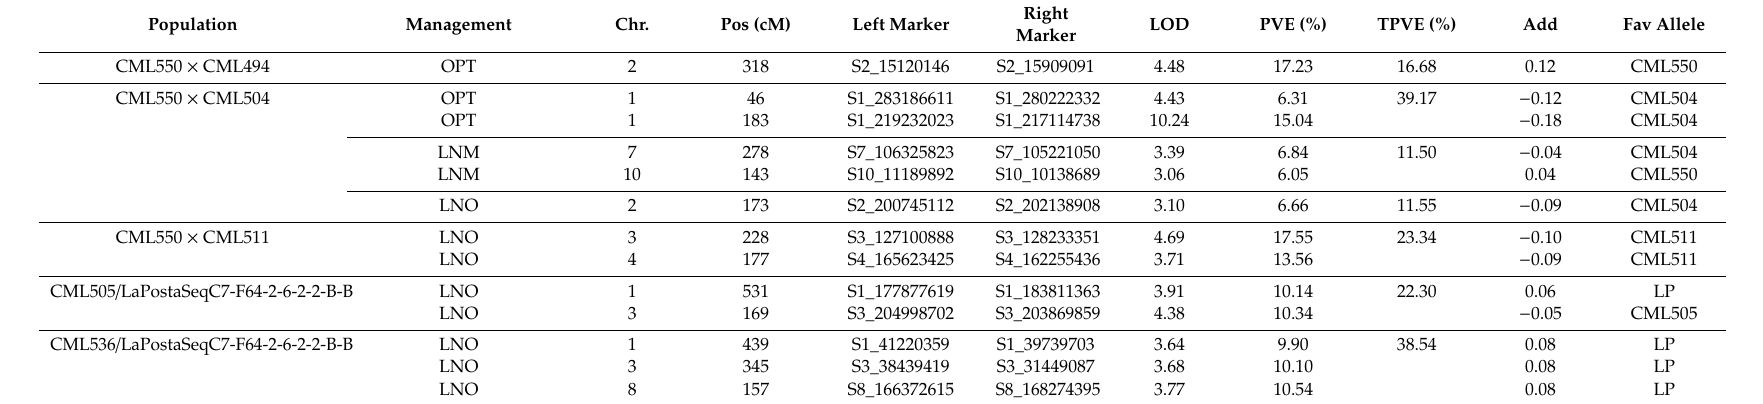
Table 3. Genetic characteristics of detected QTLs for grain yield (GY) under optimum and low-nitrogen stress in main season (LNM) and o ff -season (LNO) in DH lines derived from five bi-parental populations. Population Management Chr. Pos (cM) Left Marker